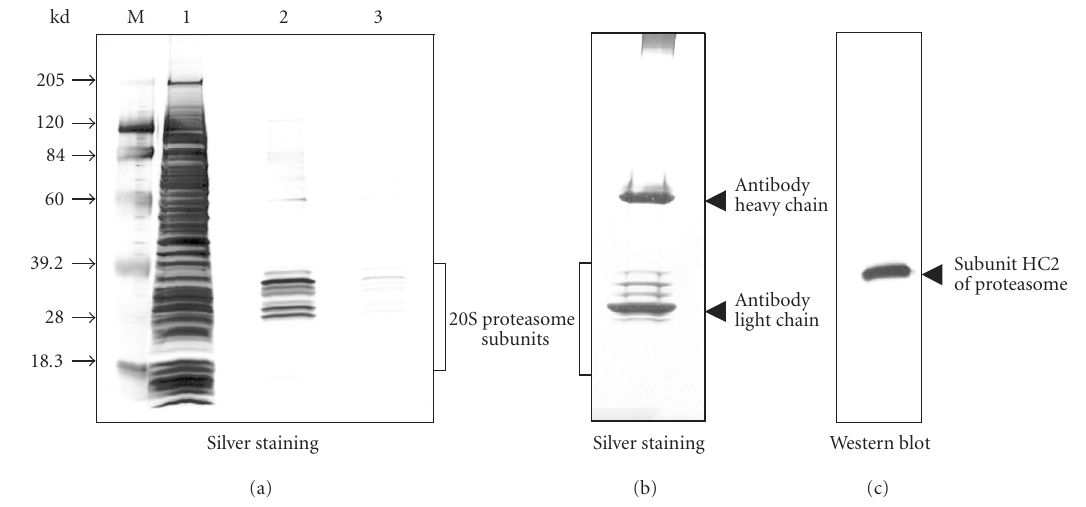
Figure 1. Comparison of co-IP using antibody cross-linked protein G agarose and non-cross-linked antibody with protein G agarose. Mouse monoclonal antiproteasome subunit α 6 antibody (100- µ L) and 100- µ L protein G resin were used for both co-IPs. HeLa cell ( ∼ 5 × 10 7 cells) lysate was precleared with protein G agarose and co-IP was performed at 4 ◦ C overnight. (a) Co-IP of 20S protea- some complex using antisubunit α 6 antibody cross-linked protein G agarose. The eluted proteasome complex was concentrated and separated on 12% SDS-PAGE and silver stained. Lane M, BlueRanger prestained protein molecular weight marker mix; lane 1, crude HeLa cell lysate; lane 2, elutions 1 and 2; lane 3, elutions 3 and 4. (b) Co-IP of 20S proteasome complex using traditional antisubunit α 6 antibody with protein G agarose. One sixth of total eluted proteasome-antibody complex was separated on 12% SDS-PAGE and silver stained. (c) Immunoblot detection of 20S proteasome subunit α 6 in crude HeLa cell lysate using anti- α 6 antibody.